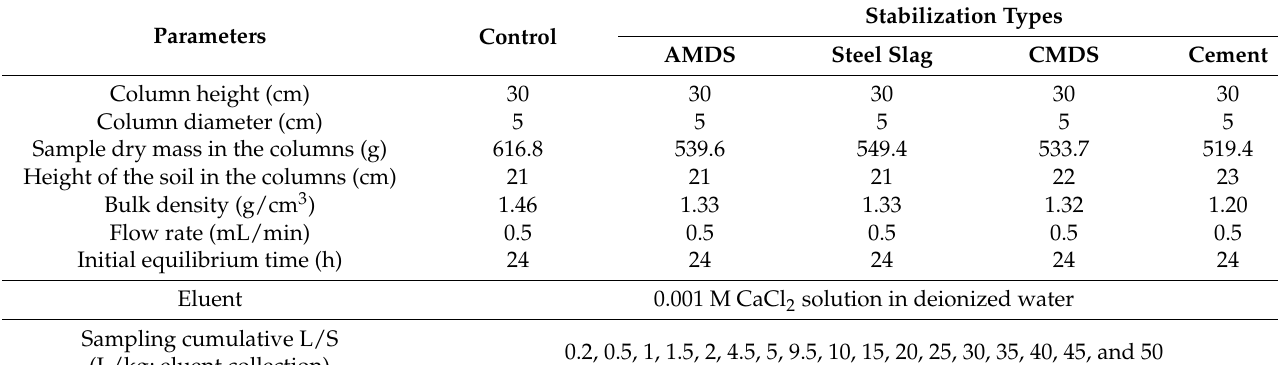
Table 2. Column dimensions and sample size within the different columns. Sample packing involved light tamping of five layers from the top to the bottom of the column. The experimental setup followed the EPA Method 1314 with slight modifications (see the methods section for